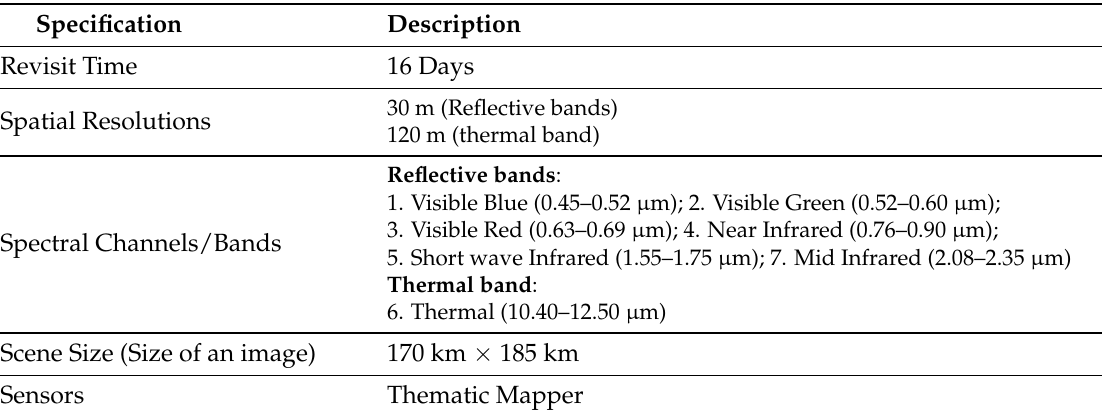
Table 1. Landsat-5 Thematic Mapper Image